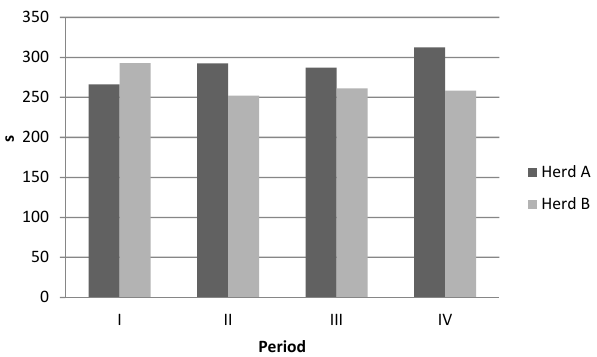
Figure 1. Levels of milk yield in herds under study.